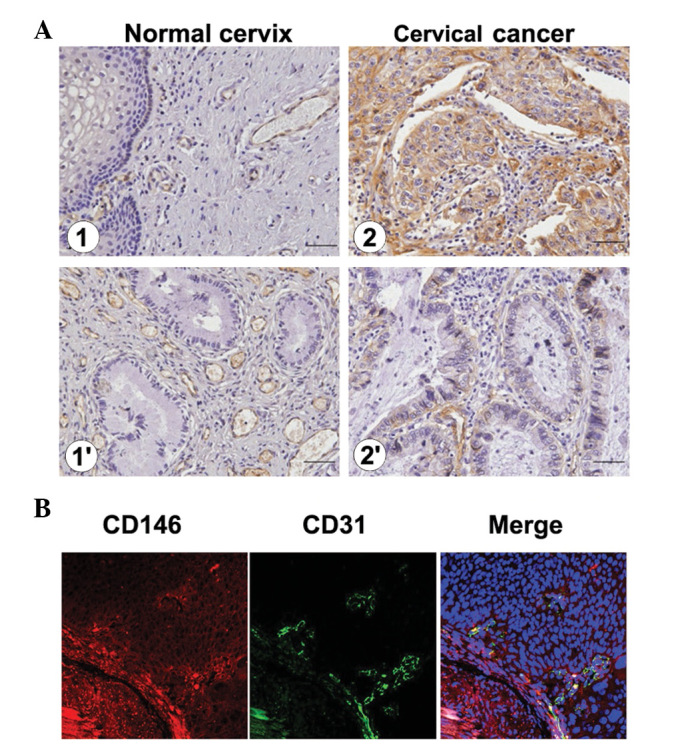
Expression of CD146 in the clinical samples of normal and cancerous cervical tissue. (A) Representative immunohistochemical staining of CD146 in vascular endothelial cells and tumor cells in the collected tissues, including: (A1) Normal cervical squamous epithelium; (A2) normal cervical mucosa glands; (A1′) cervical squamous carcinoma; and (A2′) adenocarcinoma. (B) Expression of CD146 in vascular endothelial cells was confirmed using anti-CD31 as an endothelial marker in a fluorescent immunohistochemistry assay. CD146, red; CD31, green; Merge, overlapped images of former pictures and nuclei were stained with DAPI (blue). Scale bars, 100 μm. CD146, cluster of differentiation 146.